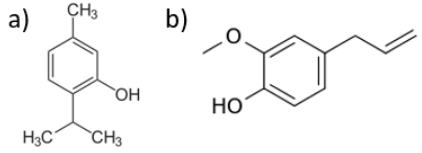
Figure 1. Chemical structure of ( a ) thymol and ( b ) eugenol.